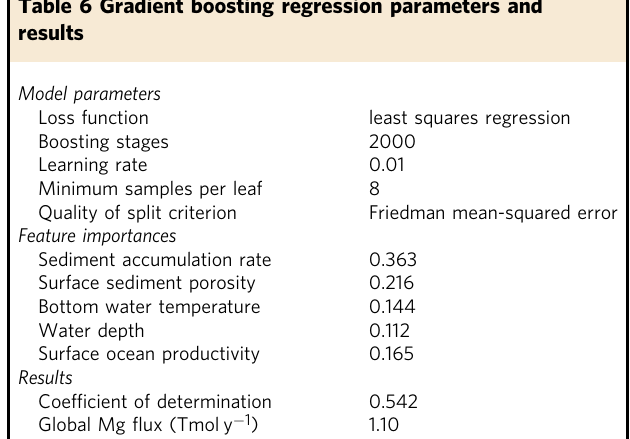
Table 6 Gradient boosting regression parameters and